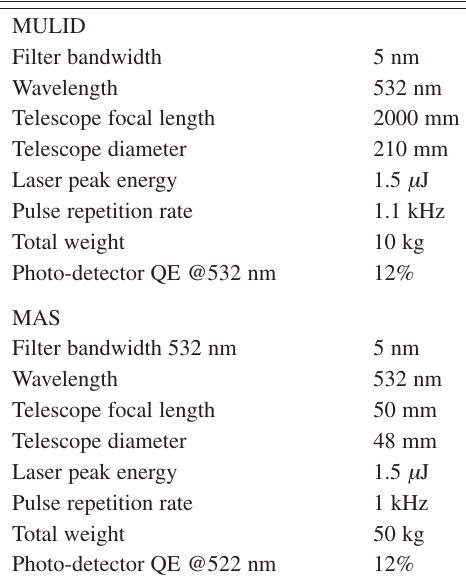
Table I. Optical and electronic characteristics of MULID and MAS